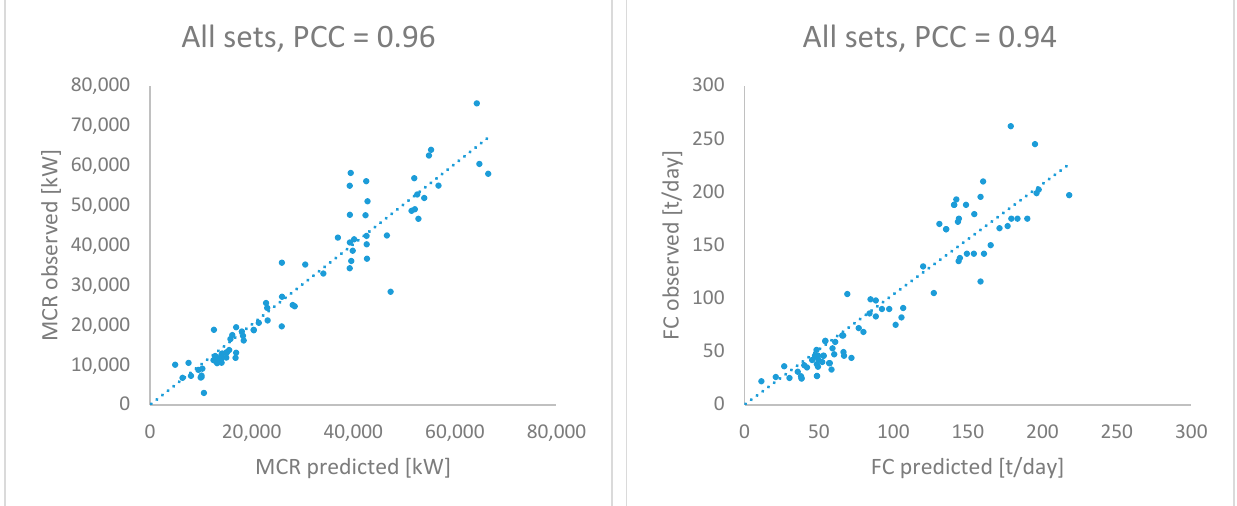
Figure 8. Regression graphs presenting the artificial neural network to estimate the engine power (MCR) and fuel consumption (FC) of container carriers.